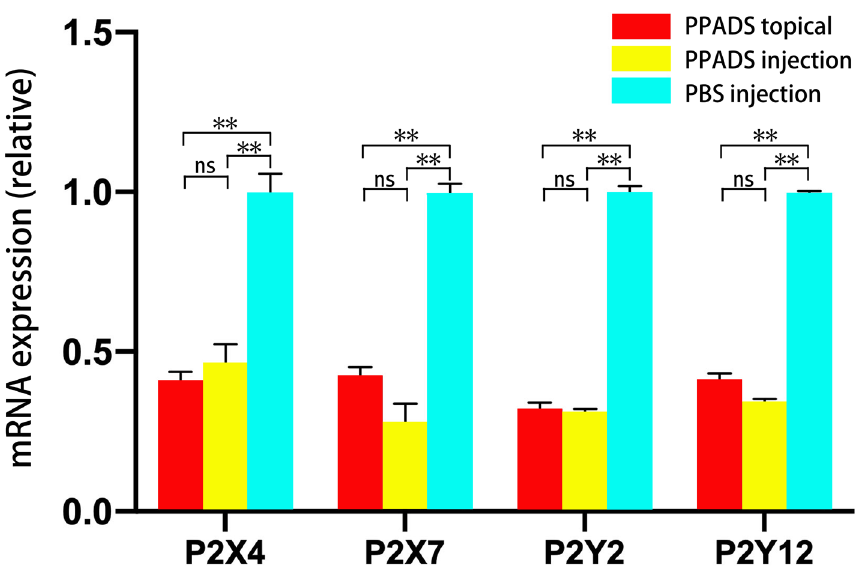
Figure 4. The expression level of P2 receptors’ mRNA on Day 4 after laser and drug treatment. (**P < 0.01, ns P >